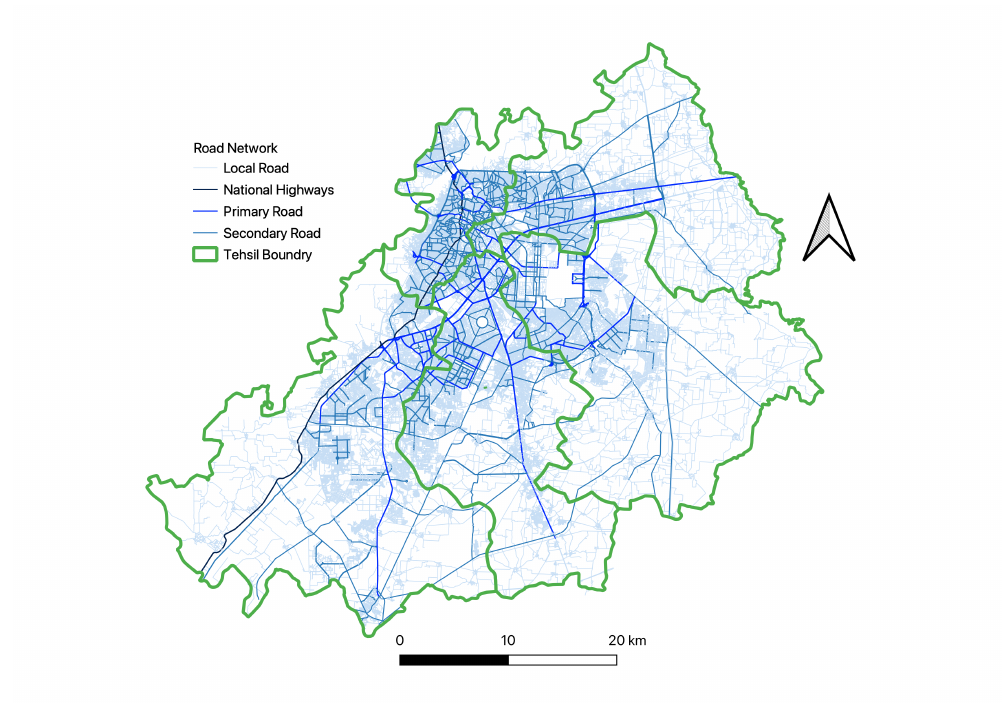
Figure 5. NTRC road network of